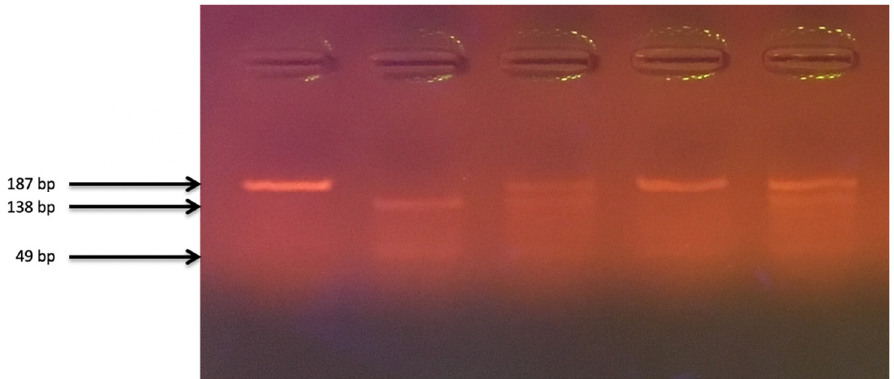
Figure 2. The electropherogram of rs10877012 polymorphism in CYP27B1 gene fragments genotyping .